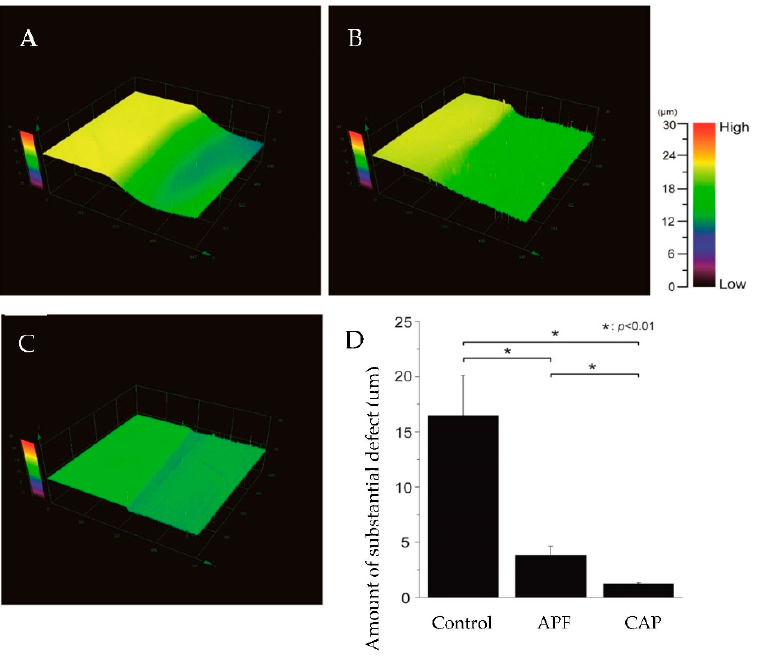
Figure 2. Height difference profiles measured using a 3D measurement laser microscope. ( A ) Boundary images of the reference and experimental surfaces after the acid challenge of the control; ( B ) APF; and ( C ) CAP system groups; ( D ) Graphical representation of substantial defects due to demineralization ( n = 5) (* p < 0.01).